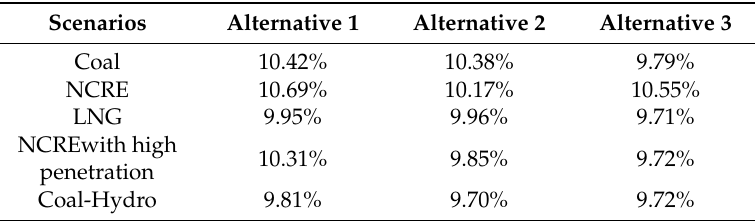
Table A2. Average price reductions by scenario and interconnection alternative.